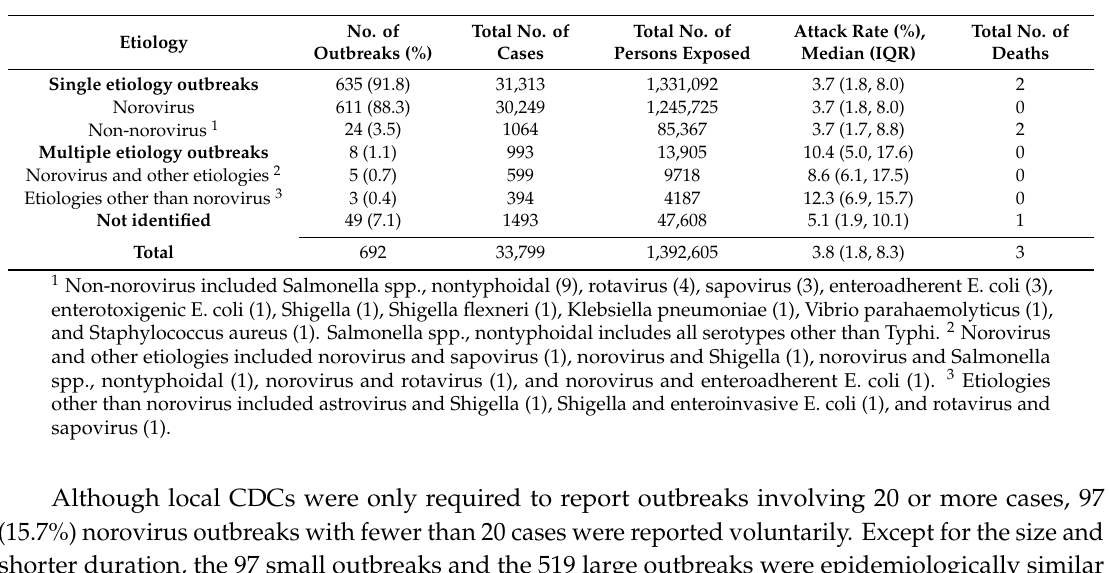
Table 1. Etiology of 692 reported acute gastroenteritis outbreaks in China, 2014–2017.